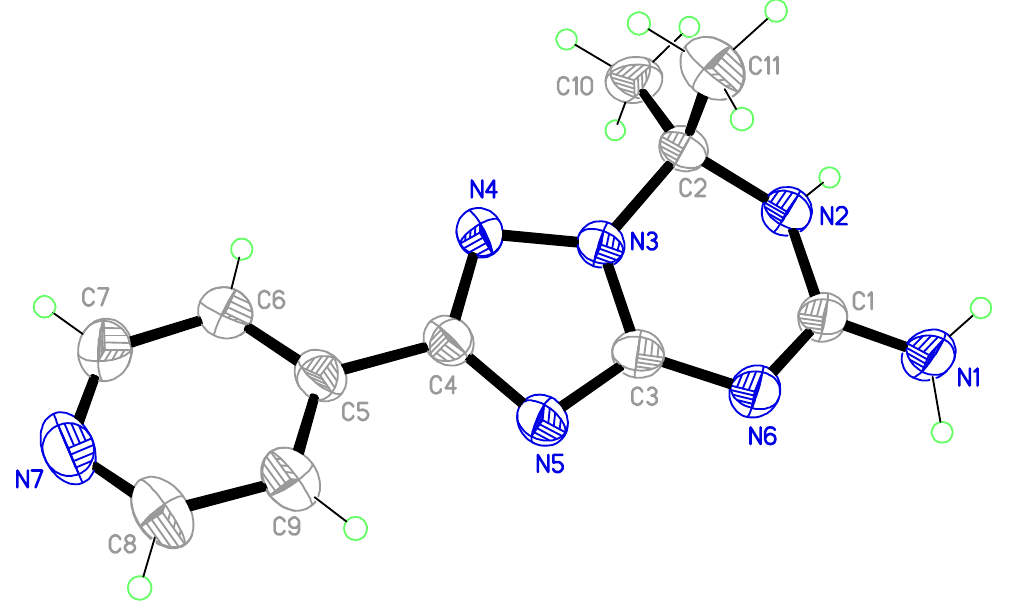
Table 2. Selected geometric parameters for 7,7-dimethyl-2-pyridin-4-yl-6,7-dihydro-